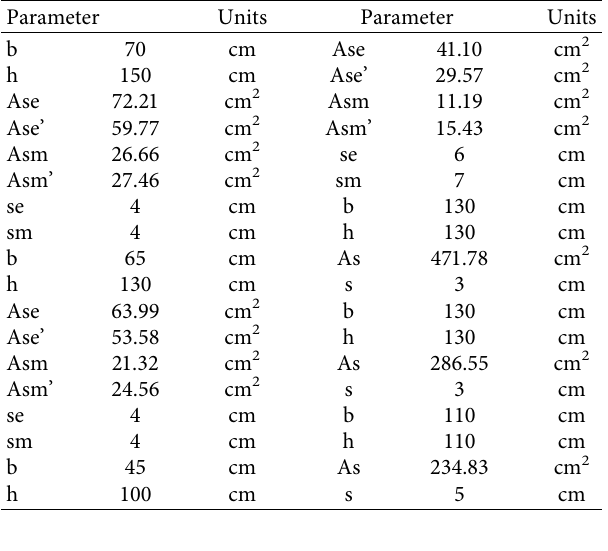
Table 3: 12-story building structural design.